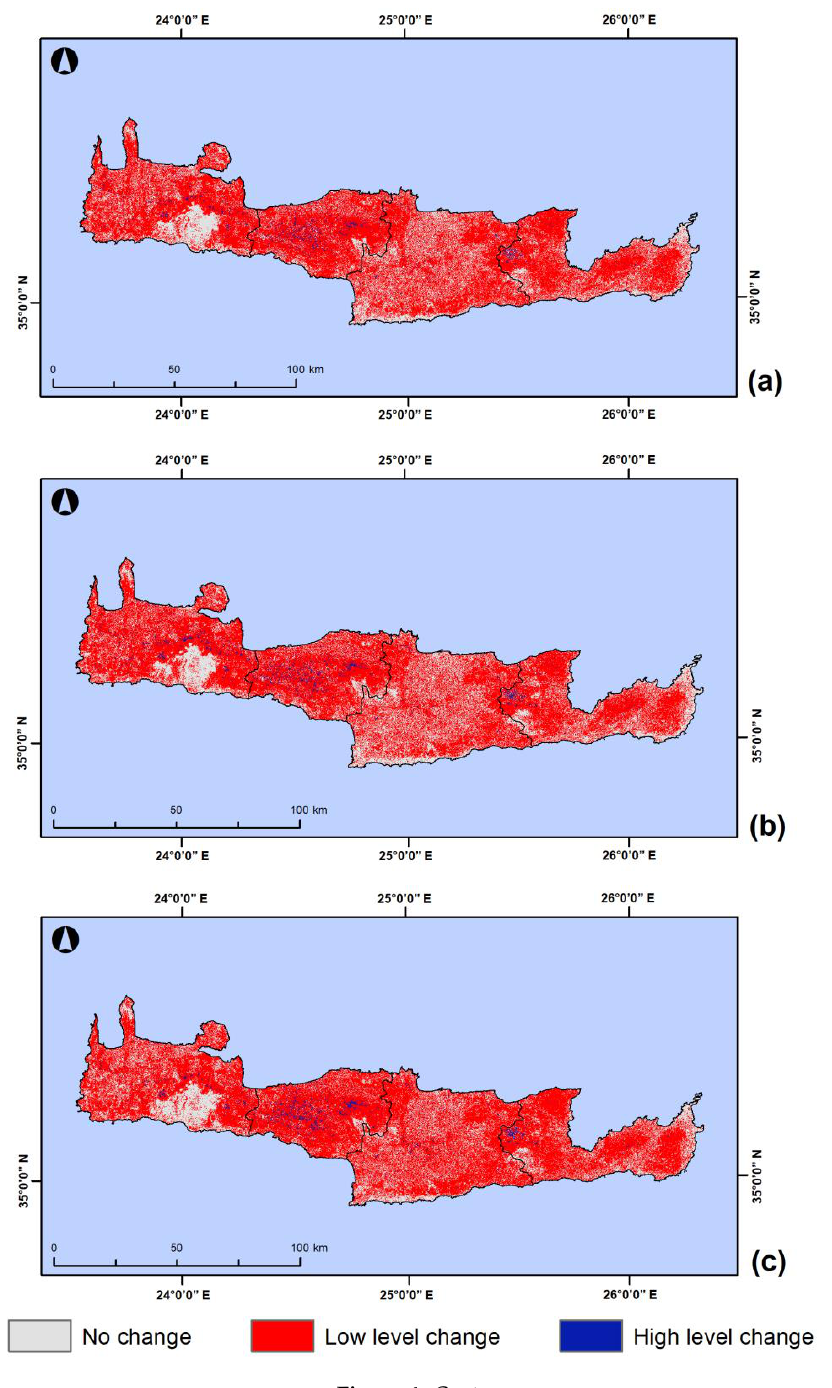
Figure 4. Cont Figure 4. Cont.